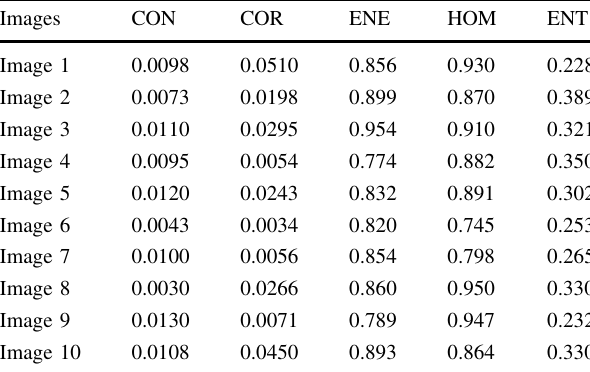
Table 2 The statistical features obtained from gray-level co-occur- rence matrix (GLCM) of LL and HL subbands of tested images Images